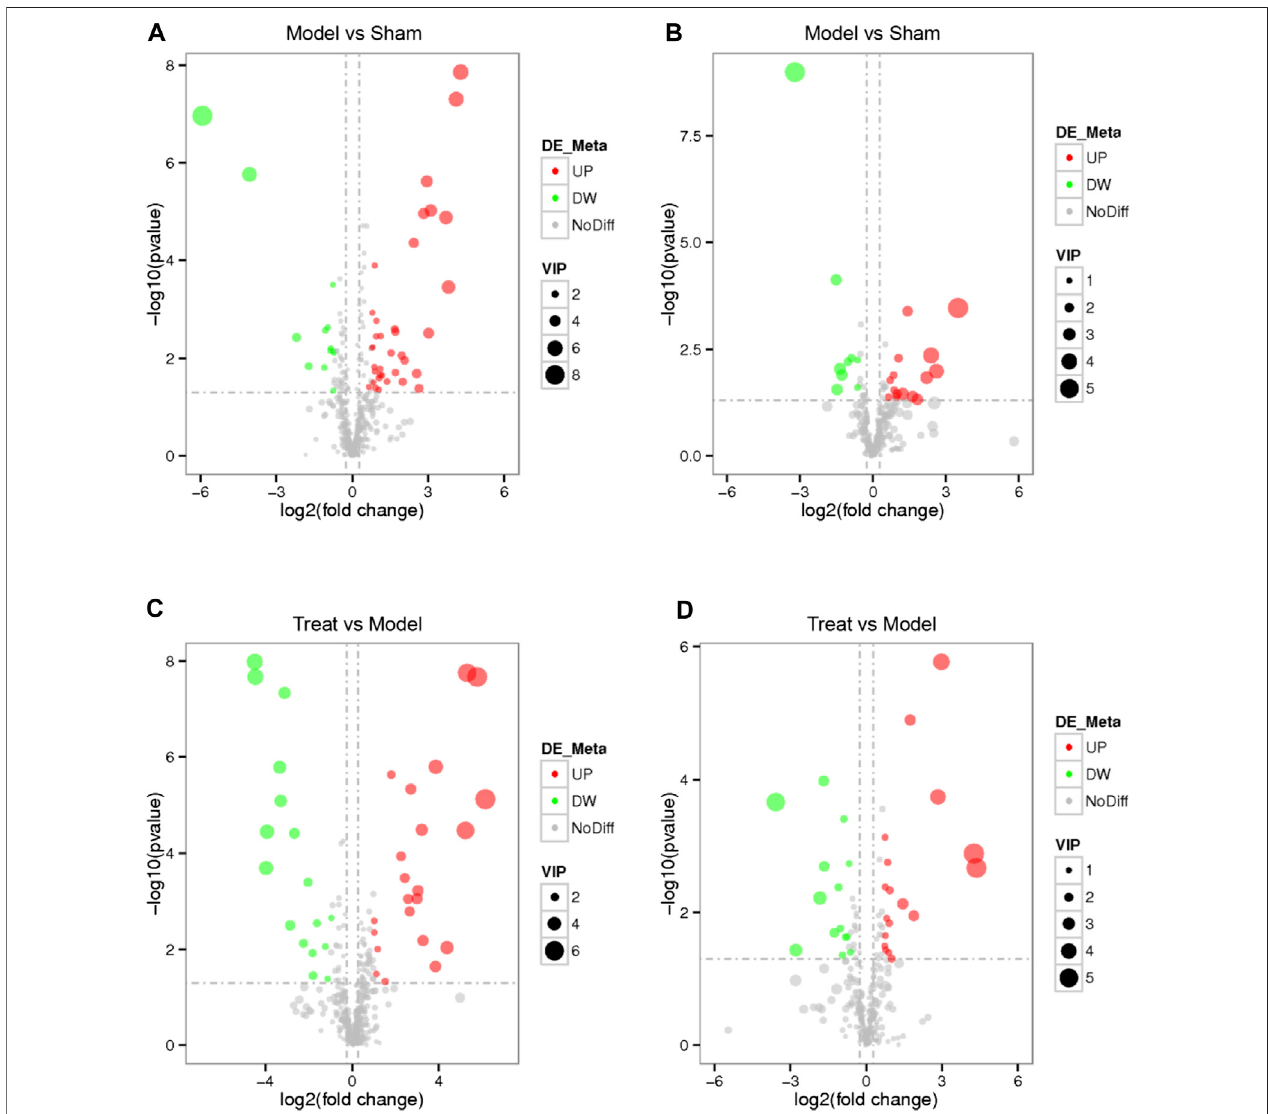
FIGURE6| VolcanomapofeverydifferentialmetaboliteamongtheModelVS.Shaminpositivemode (A) ,ModelVS.Shaminnegativemode (B) ,TreatVS.Modelin positivemode (C) and TreatVS. Model innegativemode (D) . Each dot represents ametabolite, red represents asigni fi cantly up-regulated metabolite, greenrepresents a signi fi cantly down-regulated metabolite, the size represents the VIP.